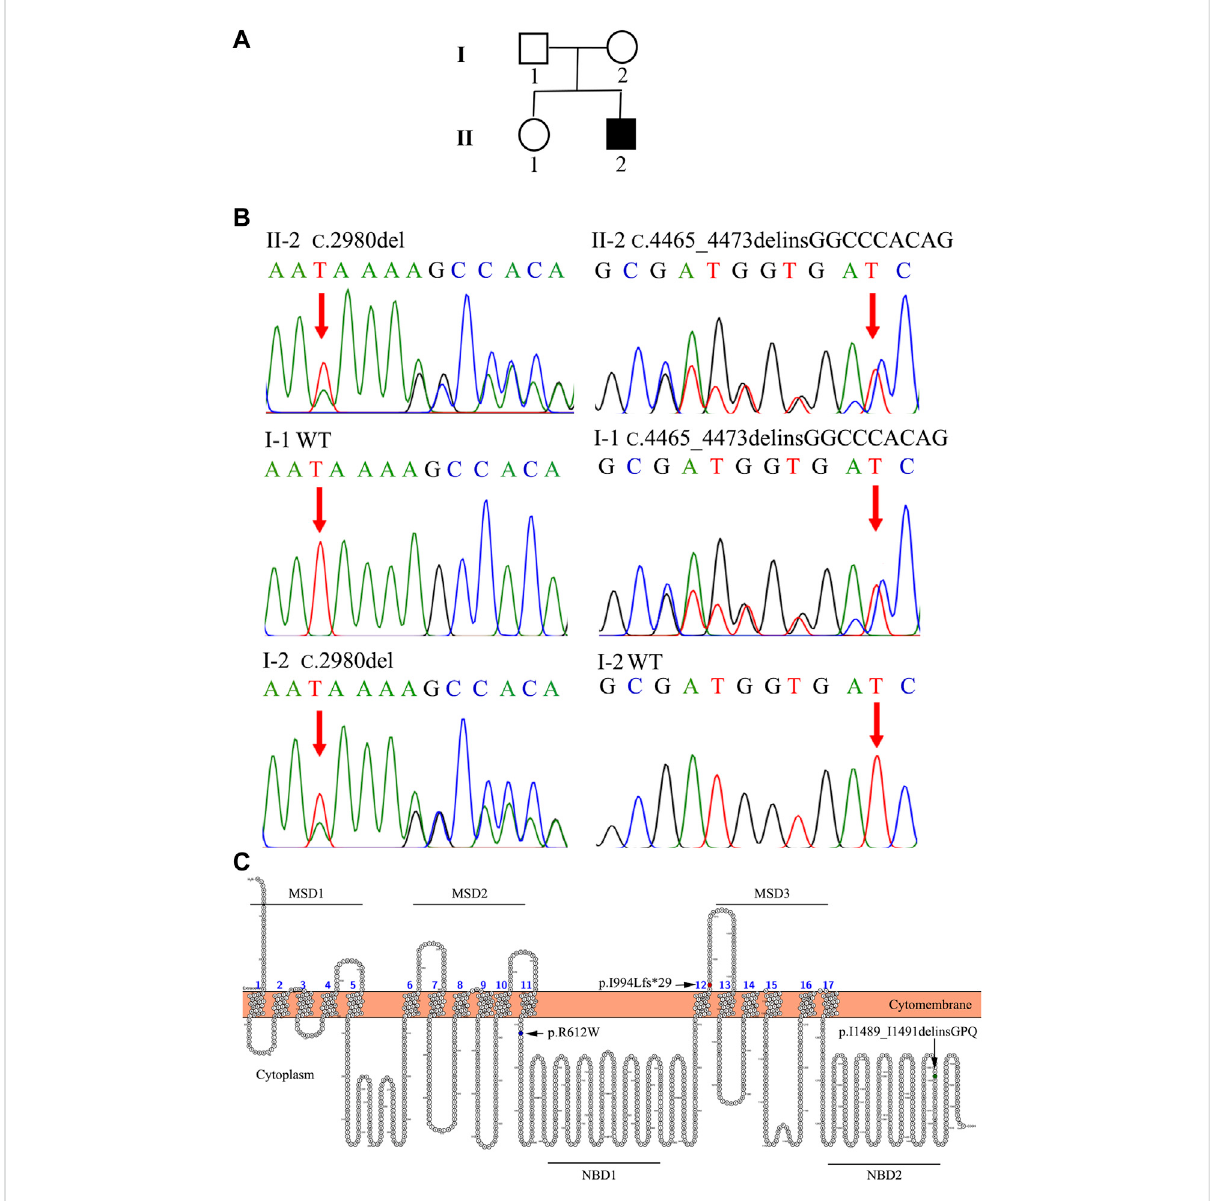
FIGURE 2 The family tree and genetic analysis of Family 2. (A) Proband II-2 suffered from DJS. (B) Direct sequencing showed a compound heterozygous (c.2980delA and c.4465_4473 delinsGGCCCACAG) ABCC2 mutation in II-2. I-1 was affected with the heterozygous c.4465_4473delinsGGCCCACAG mutation. II-2 harbored the heterozygous c.2980delA variant. (C) Locations of the mutations in MRP2. The schematic diagram of MRP2 was generated using Protter software (http://wlab.ethz.ch/protter/start/). MSD: membrane spanning domains, NBD: nucleotide binding